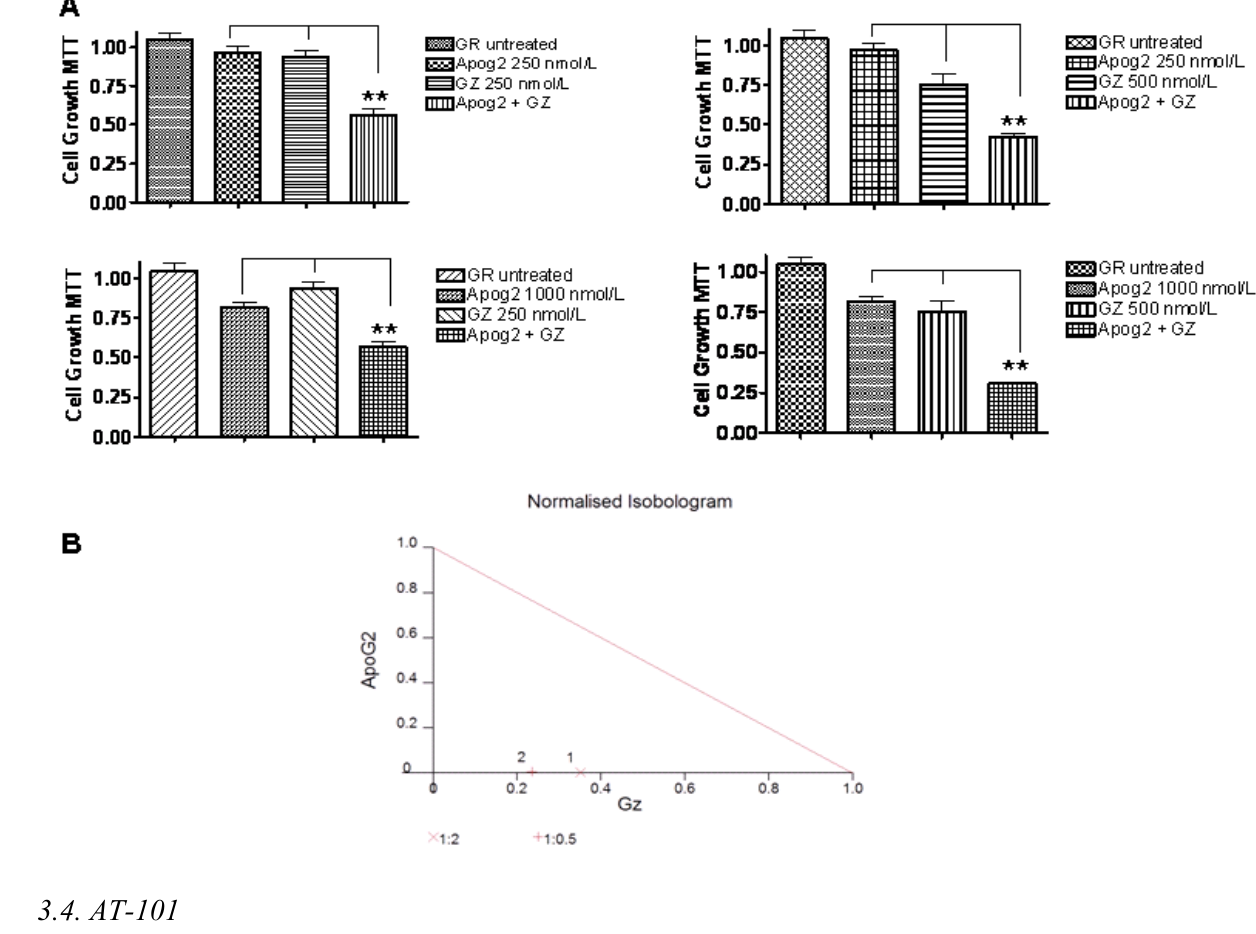
Figure 2. Bcl-2 family inhibitor ApoG2 synergizes with gemcitabine. ( A ) ApoG2 synergizes with gemcitabine and induces superior growth inhibition compared to single agents in gemcitabine resistant PC cells (MiaPaCa-GR). MiaPaCa-GR cells were developed by growing MiaPaCa-2 cells in 100 nm gemcitabine-containing media for 4 weeks. The cells were exposed to the indicated concentrations of (top and bottom panels) ApoG2 (250 nmol/L and 1000 nmol/L); gemcitabine (250 nmol/L; 500 nmol/L) or their respective combinations for 72 hrs (multiple concentrations were used to obtain statistically relevant and Isobologram analysis eligible data). Growth inhibition was analyzed by MTT assay. Note the combination has greater growth inhibition than single agent treatment. ( B ) Isobologram analysis for synergistic interaction using Calcusyn software. Combination index <1 means synergy. ** p<0.01 single agent vs. combination treatment. At similar doses, ApoG2 does not induce growth inhibition or apoptosis in normal human pancreatic ductal epithelial cells